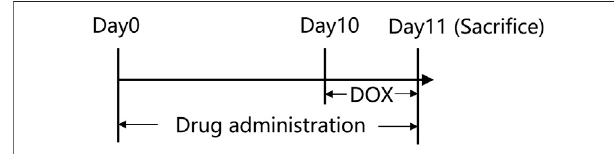
FIGURE 1 | A diagram of the experiment design in